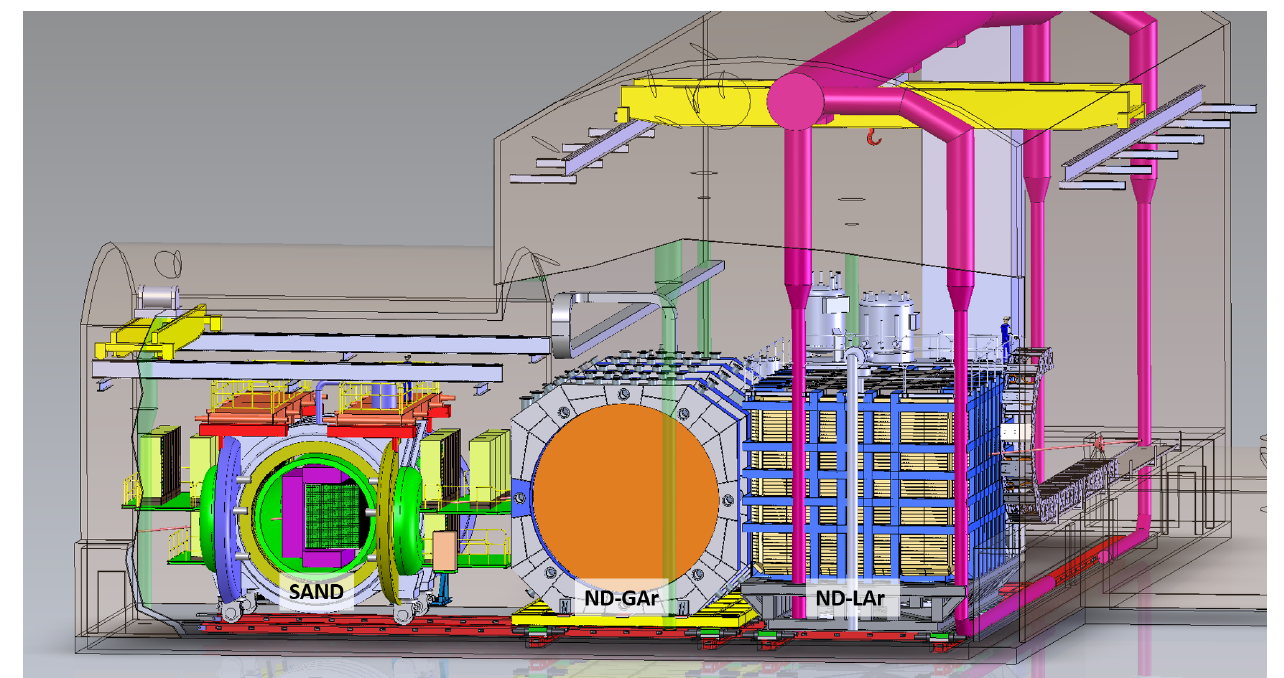
Figure 4. Illustration of the ND hall, showing the detector subcomponents. With respect to a beam, which points from right to left in this image, ND-LAr is the most upstream component and immediately downstream is ND-GAr, which serves ND-LAr as a muon spectrometer. Beyond ND-GAr is SAND. The person on top of ND-LAr is an indication of